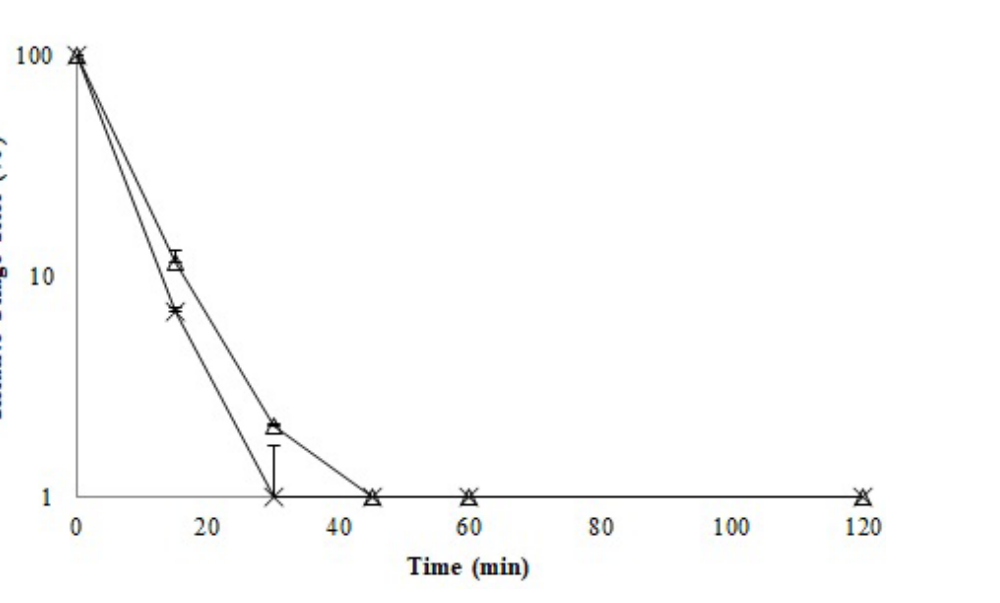
Figure 5: Survival of the B . cereus bacteriophages BaceFT01 (Δ) and BaceCM02 (×) after 2 h at 37°C in TSB broths with different pH values in the range of 3 – 13.